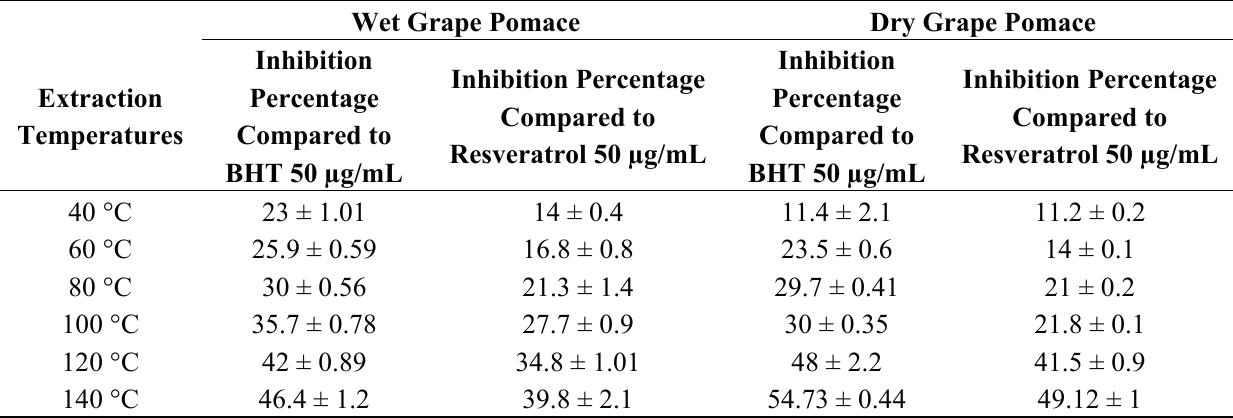
Table 2. 2,2-Diphenyl-picrylhydrazyl (DPPH) free radical inhibition percentage values for the dry and wet pomace extracts (50 µg/mL) compared to Resveratrol and 2,6-di- tert -butyl- 4-methylphenol (BHT) (50